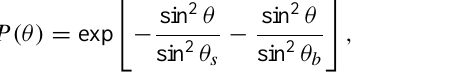
Fig. 4. Scatter diagram of the characteristic width obtained from the Capon CRI and the e − 1 half-width of the effective polar diagram calculated from a FCA analysis with SNR larger that 5 dB. Taken from Yu